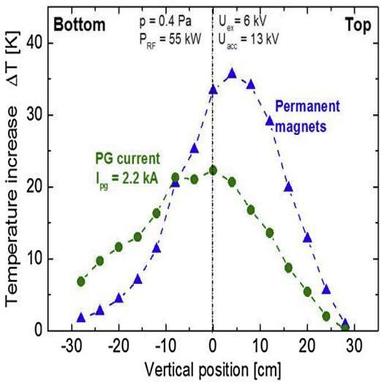
Beam profile measured with the thermocouples in the calorimeter for the filter field created by the PG current and by permanent magnets.